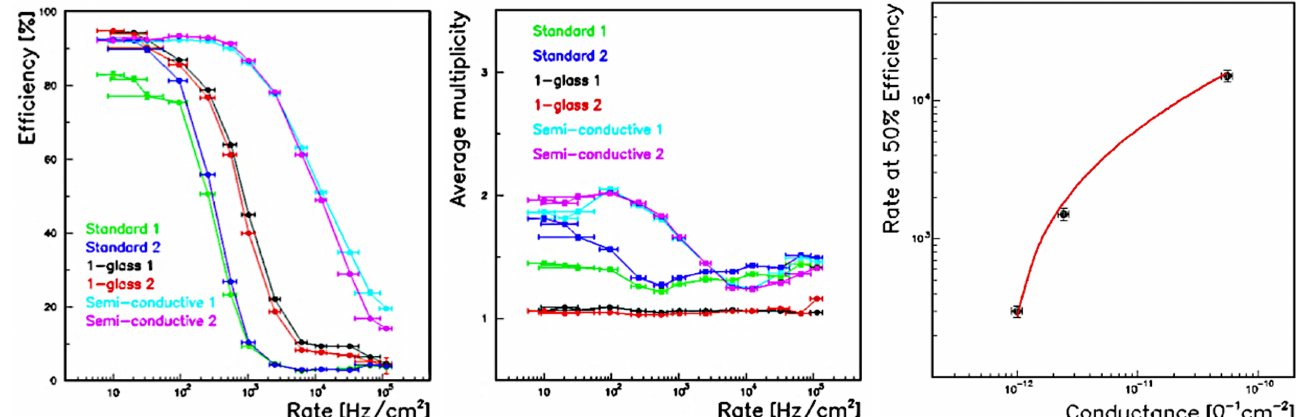
Figure 3. The efficiency ( left ) and the average pad multiplicity ( center ) as a function of beam rate for six different RPCs, and the rate at 50% efficiency as a function of conductance per area of the glass plates ( right